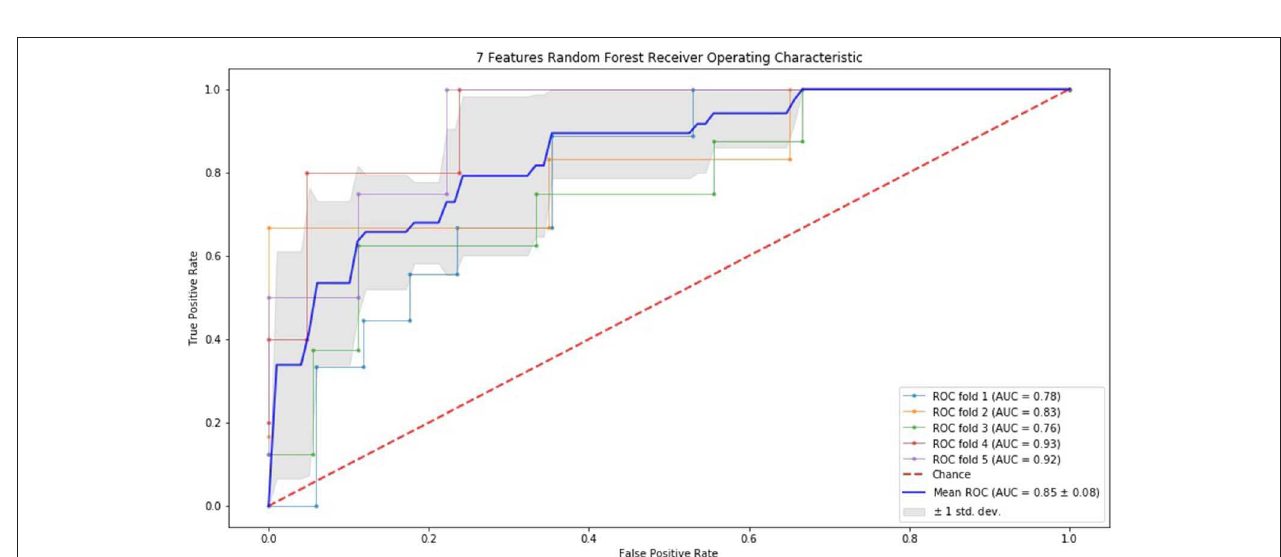
FIGURE 5 | ROC of 5-fold cross validation results of RF. The mean AUC of 5 features was 0.81 ± 0.08.